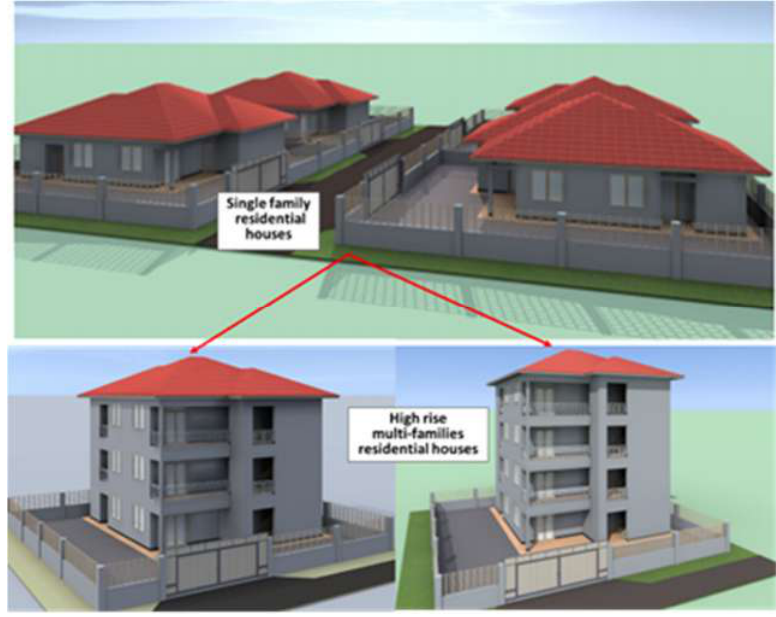
Figure 4. Self-help construction using durable material in a condominium approach. Data source: authors’ design.